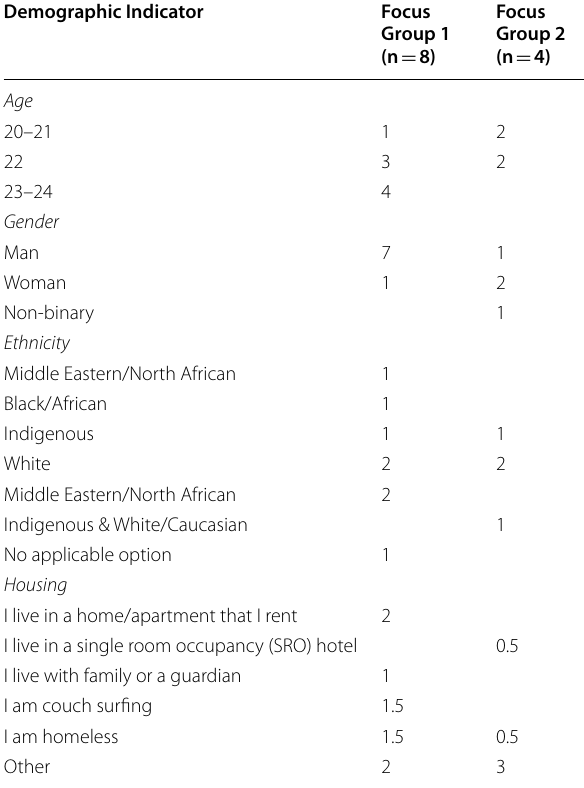
Table 1 Participate demographics. For those who indicated more than one option, a ratio is shown Demographic